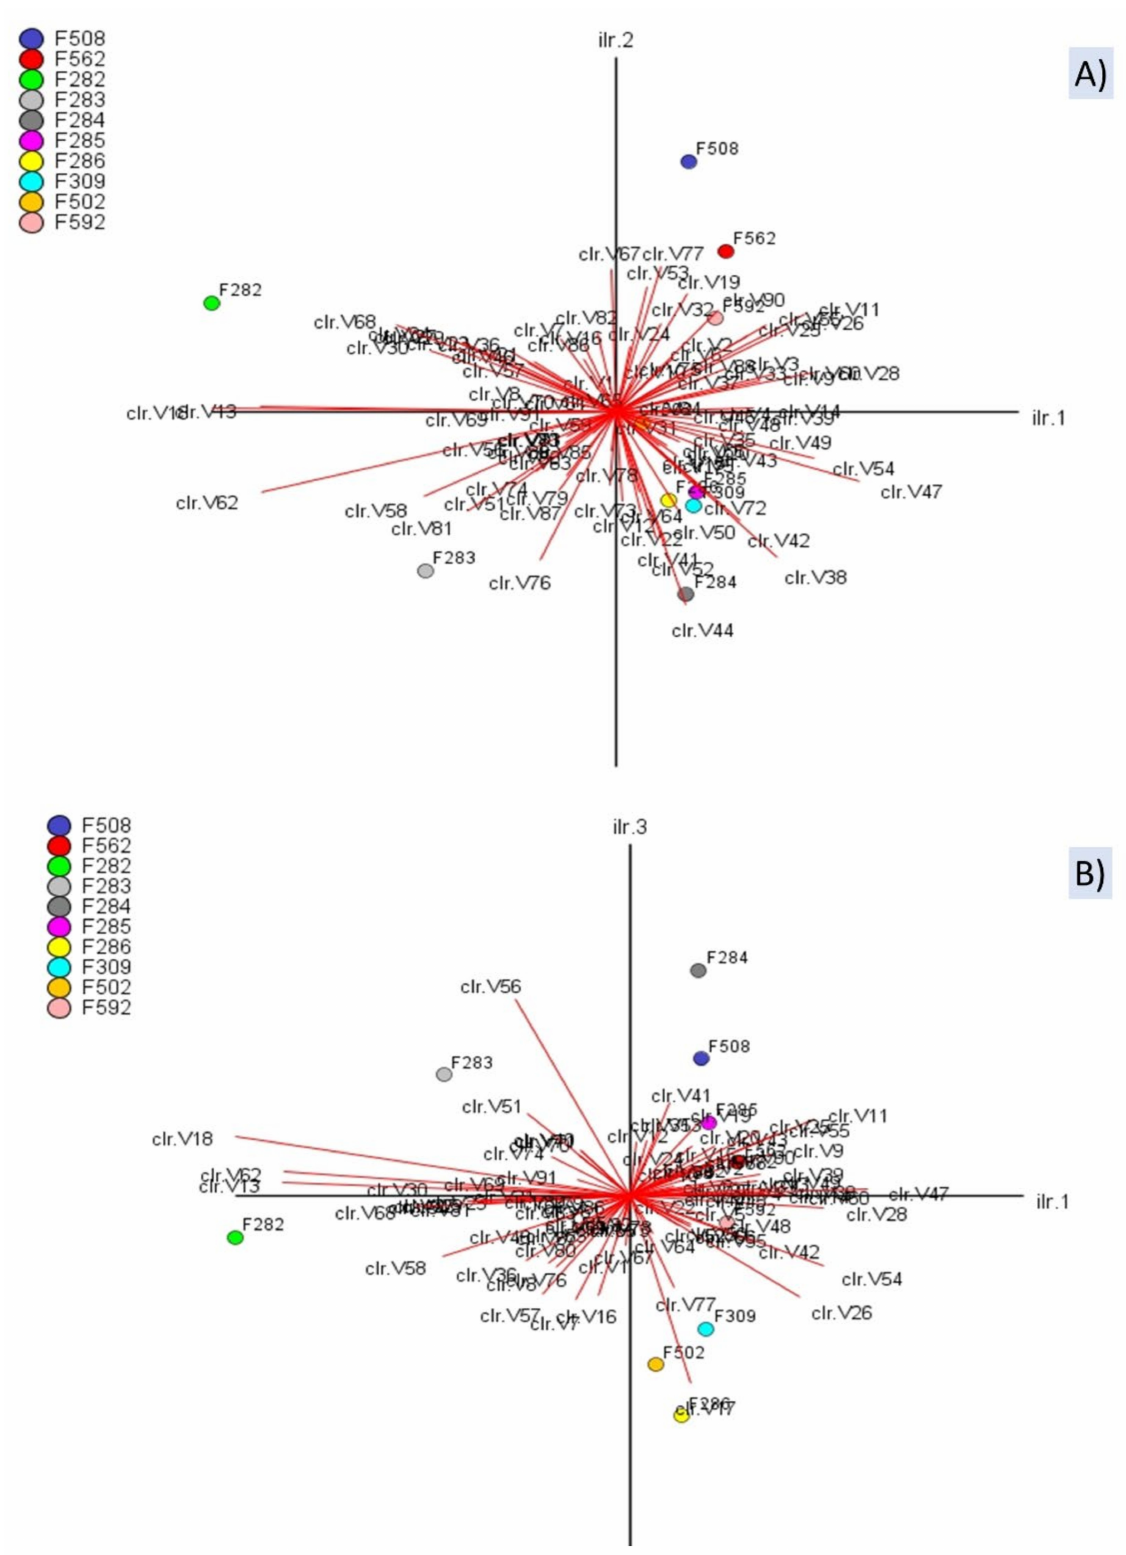
Figure 5. CoDa biplot of the VOCs and samples. Projections on the planes 1st vs 2nd ( A ) and 1st vs 3rd ( B ) dimensions. Symbols of samples correspond to industry A (F282 and F283, affected by butyric; F284, F285, F286, and F309, normal fer- mentations) and industry B (F508 and F562, sulfidic and putrid spoilage, respectively; F502 and F592, normal fermentations). Symbols for VOCs are detailed in Table S1 and S2, and S3. clr stands for clr coefficients